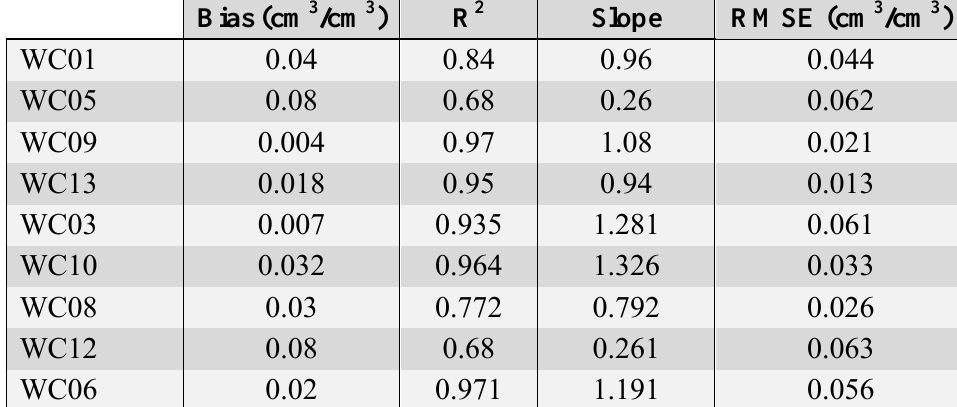
Table 2 . Regression statistics of the relationship between mean field soil moisture and mean watershed soil